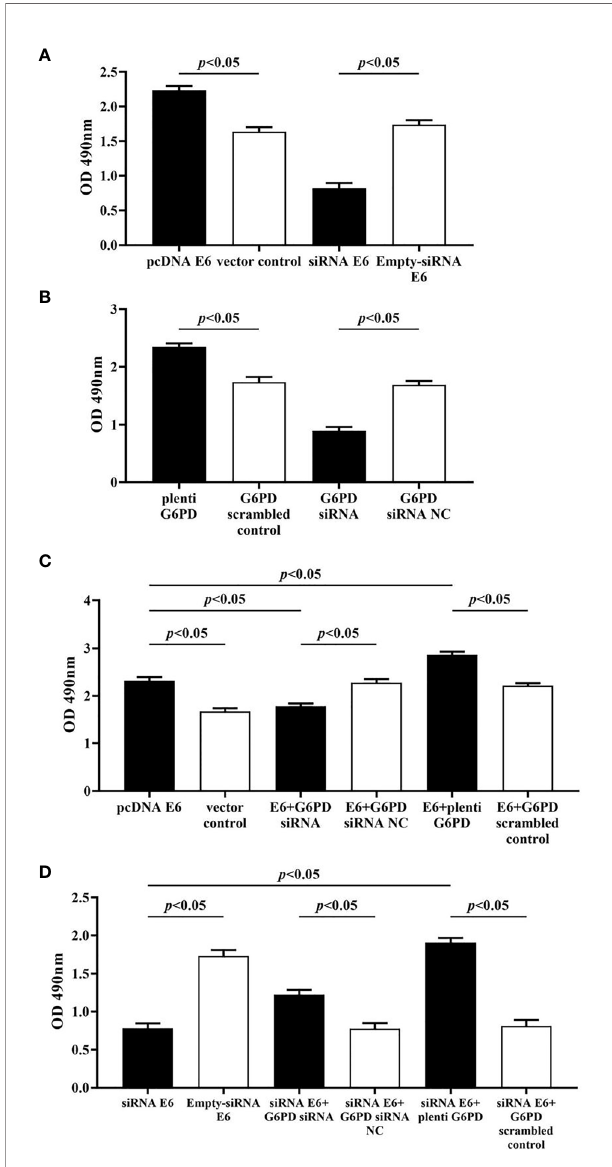
FIGURE 7 | Changes in proliferation activity of HeLa cells with different treatments. The statistical plots of the cell viability changes in groups that transfected with pcDNA E6 or siRNA E6 (A) alone, plenti G6PD or G6PD siRNA (B) alone, as well as combining these treatments (C, D) . Data are presented as means ± SD (n =